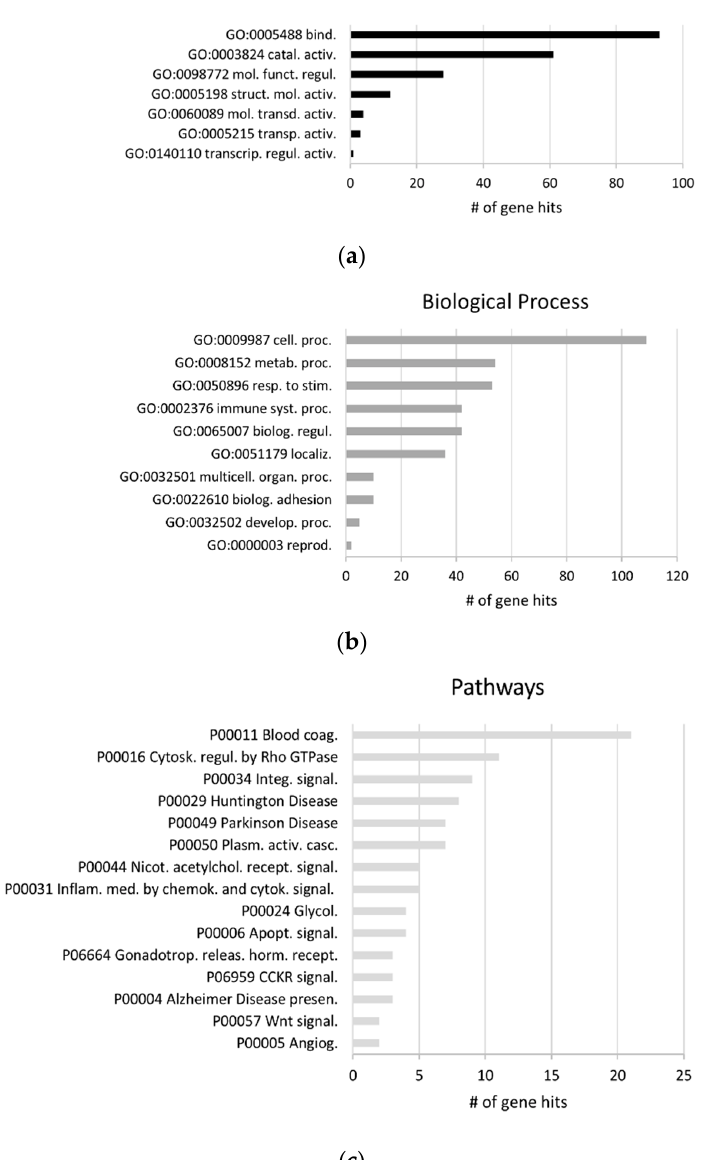
Figure 4. GO analysis of the shared exosomal proteome. Shared exosomal proteome associated molecular functions ( a ), biological processes ( b ) and pathways ( c ). GO analysis was performed for gene lists corresponding to the exosomal proteomes from serum, plasma and CSF, through the Panther classification system. Abbreviations of molecular function GOs terms: GO:0005488 bind-